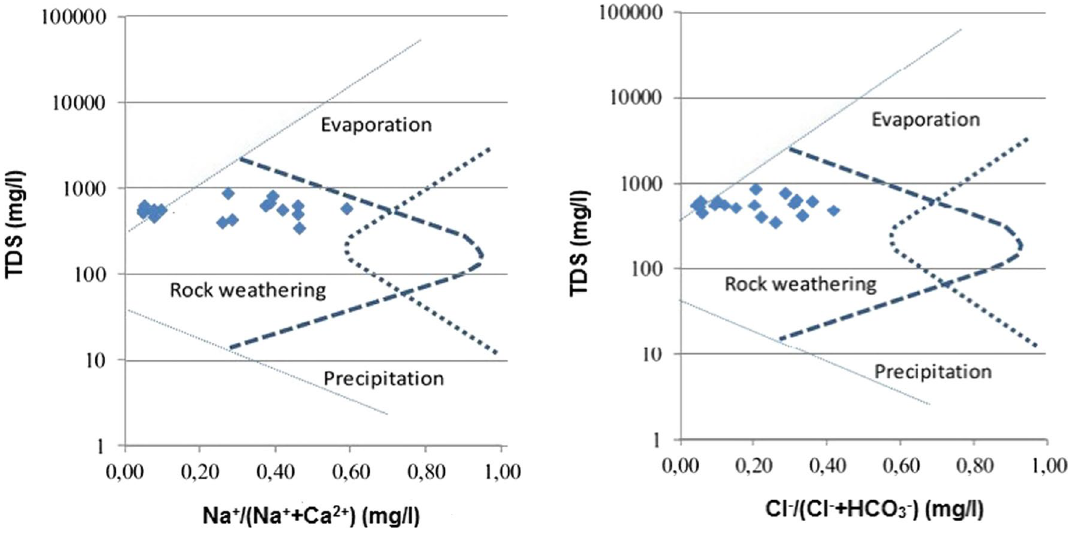
Fig. 5 Gibbs diagram of the groundwater samples